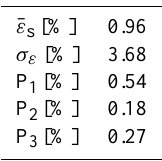
Fig. 13. Representation of mean (solid black line), median (solid grey line) and 10% and 90% percentiles (broken grey and black lines) of relative error for different durations. Table 9. Indexes of reliability calculated on FDC obtained from the regionalisation